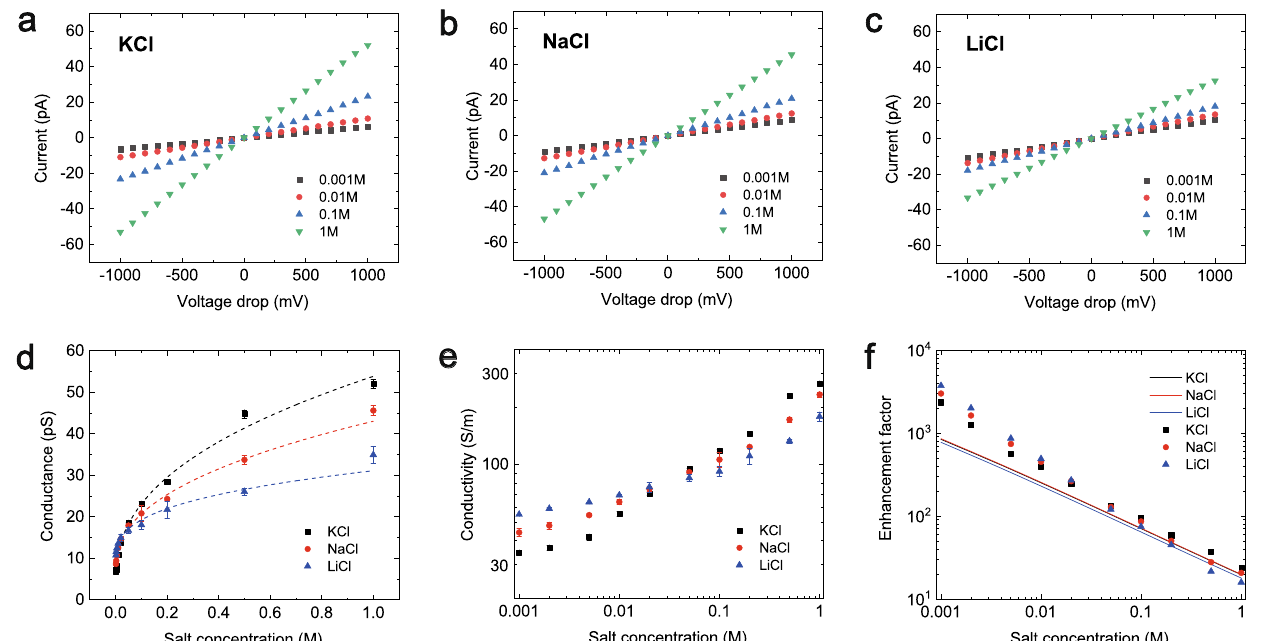
Fig. 4 | Ionic conductance of individual carbon nanotube nano fl uidic device. For single carbon nanotube nanochannel, a – c show the I – V curves recorded at differentsolutionconcentrationswith( a )KCl,( b )NaCl,and( c )LiCl. d Nanochannel ionicconductance, e conductivity,and f conductivityenhancementasafunctionof